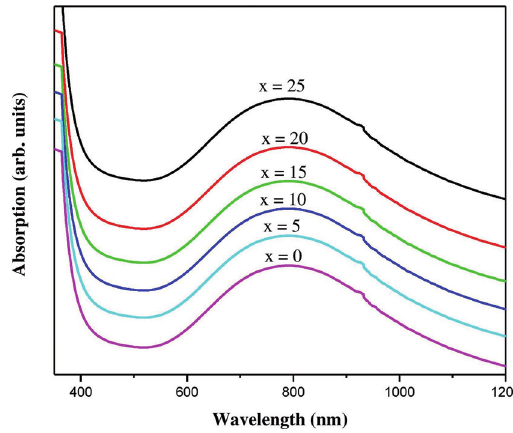
Figure 3: Optical absorption spectra of present glass system.